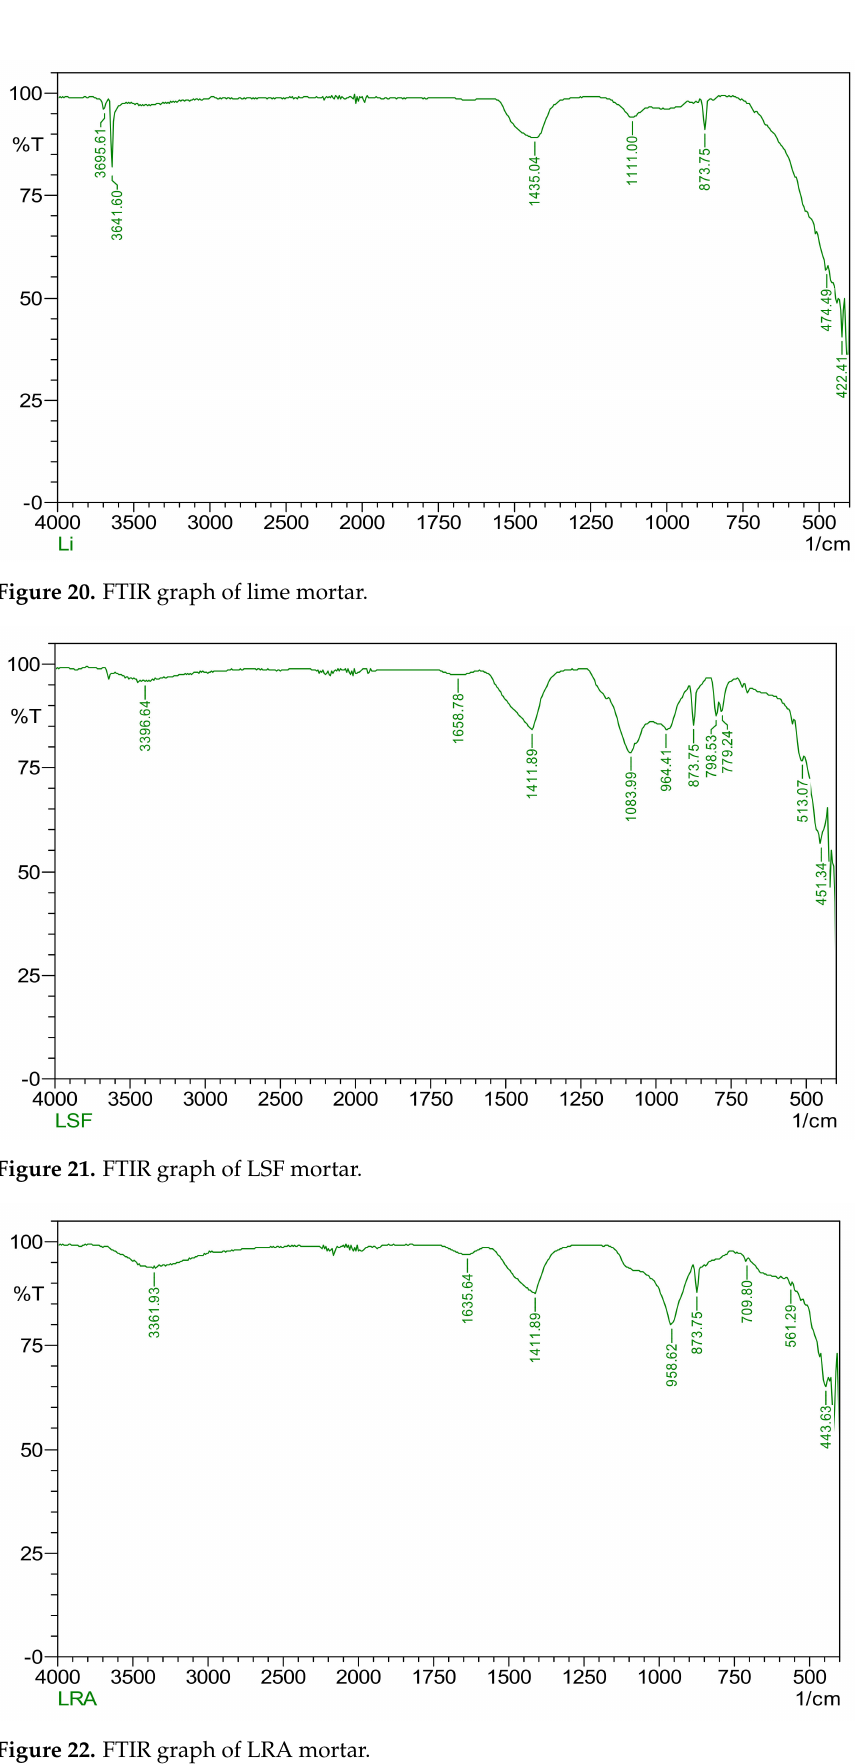
Figure 22. FTIR graph of LRA